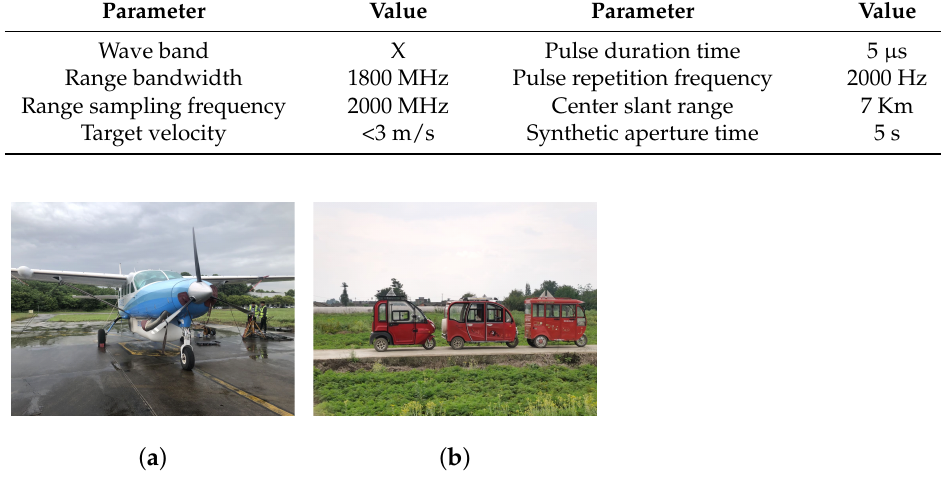
Figure 9. Flying platform and cooperation targets. ( a ) Flying platform. ( b ) Cooperation